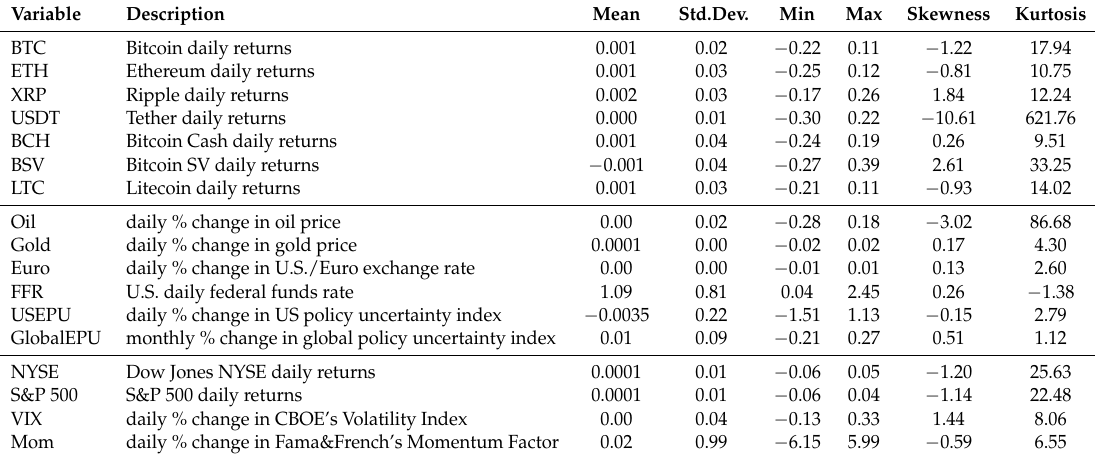
Table 3. Descriptive statistics for cryptocurrencies, stocks, commodities, gold and Forex